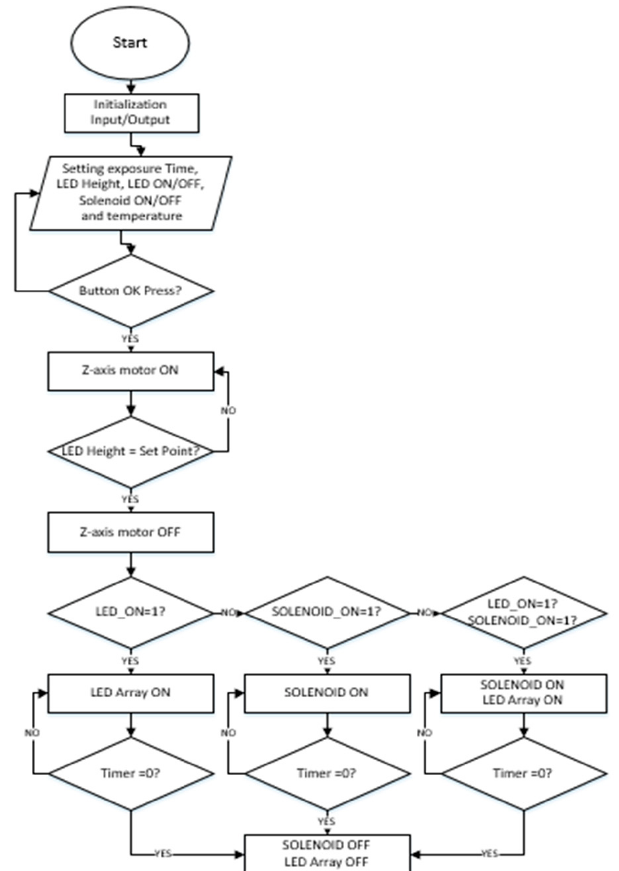
Figure 5. Flowchart software design .